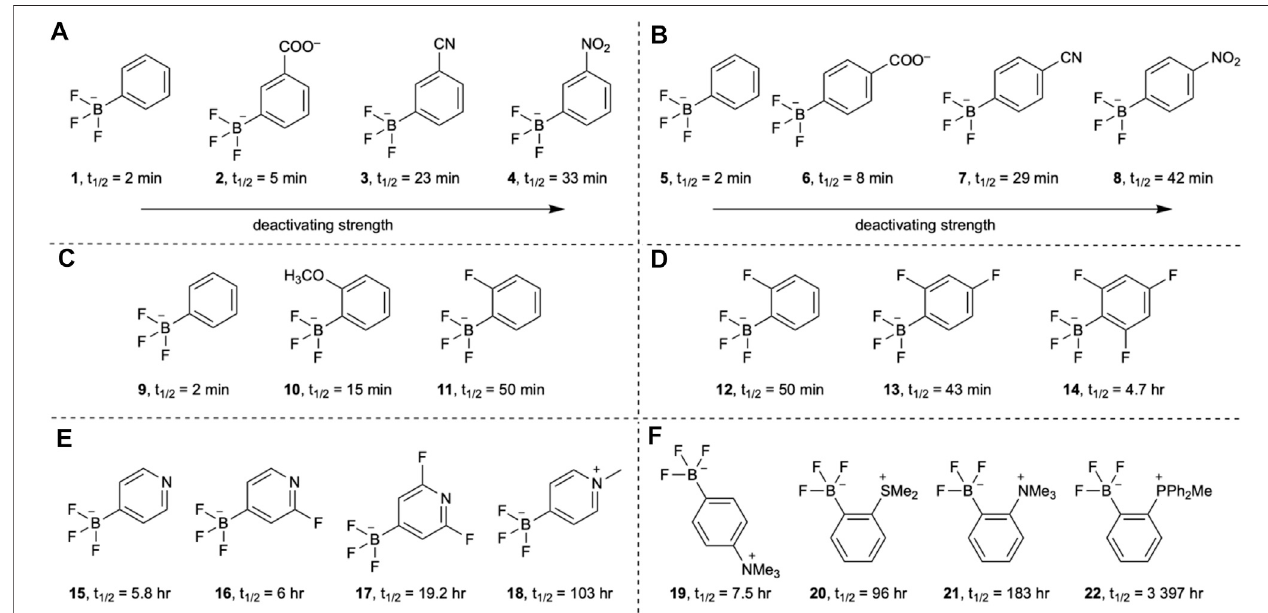
FIGURE2| Theeffectsofaromaticsubstitutiononthehydrolytichalf-lifeoftheB-Fbondofaryltri fl uoroborates.ThehydrolyticstabilityoftheB-Fbondisin fl uenced by (A) meta substituents, (B) para substituents, (C) ortho substituents, (D) electron withdrawing fl uorine substituents, (E) heteroaromatic effects, and (F) zwitterionic substituents.